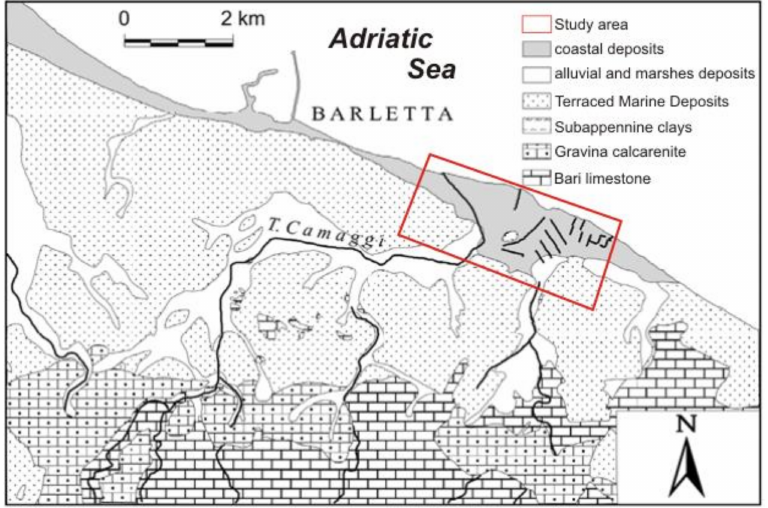
Figure 3. Geological setup of the area (modified after Caldara et al., 1998